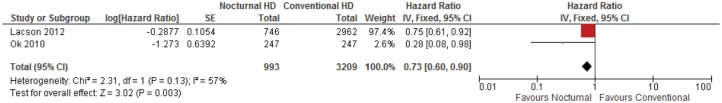
Comparative risk of mortality in nocturnal in-center HD versus conventional HD.